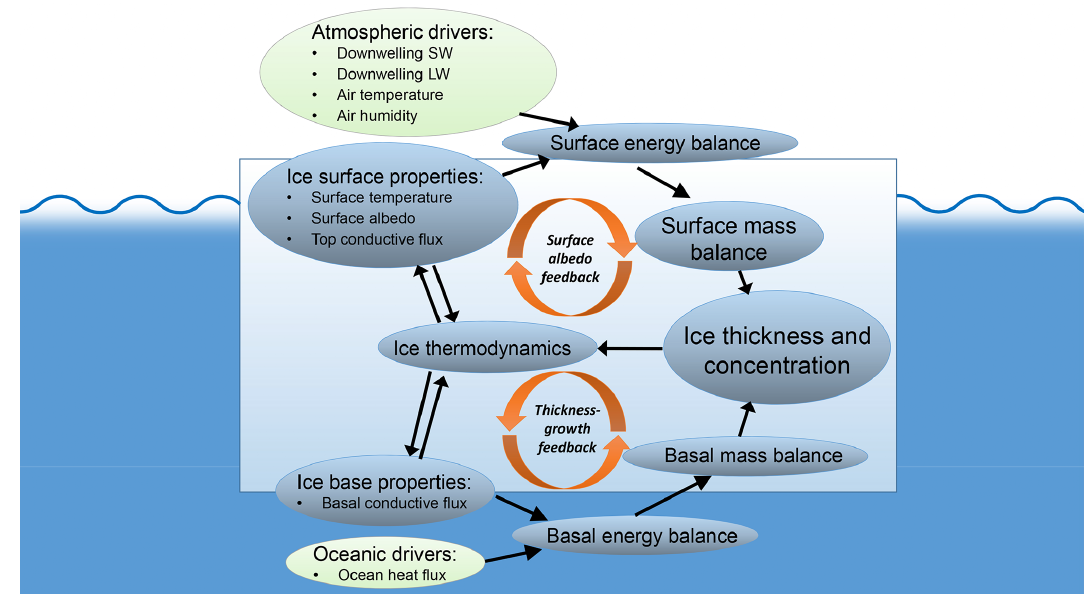
Figure 1. Schematic demonstrating the causal links between the ice thickness and extent and the mass balance at the top and basal surfaces of the sea ice.